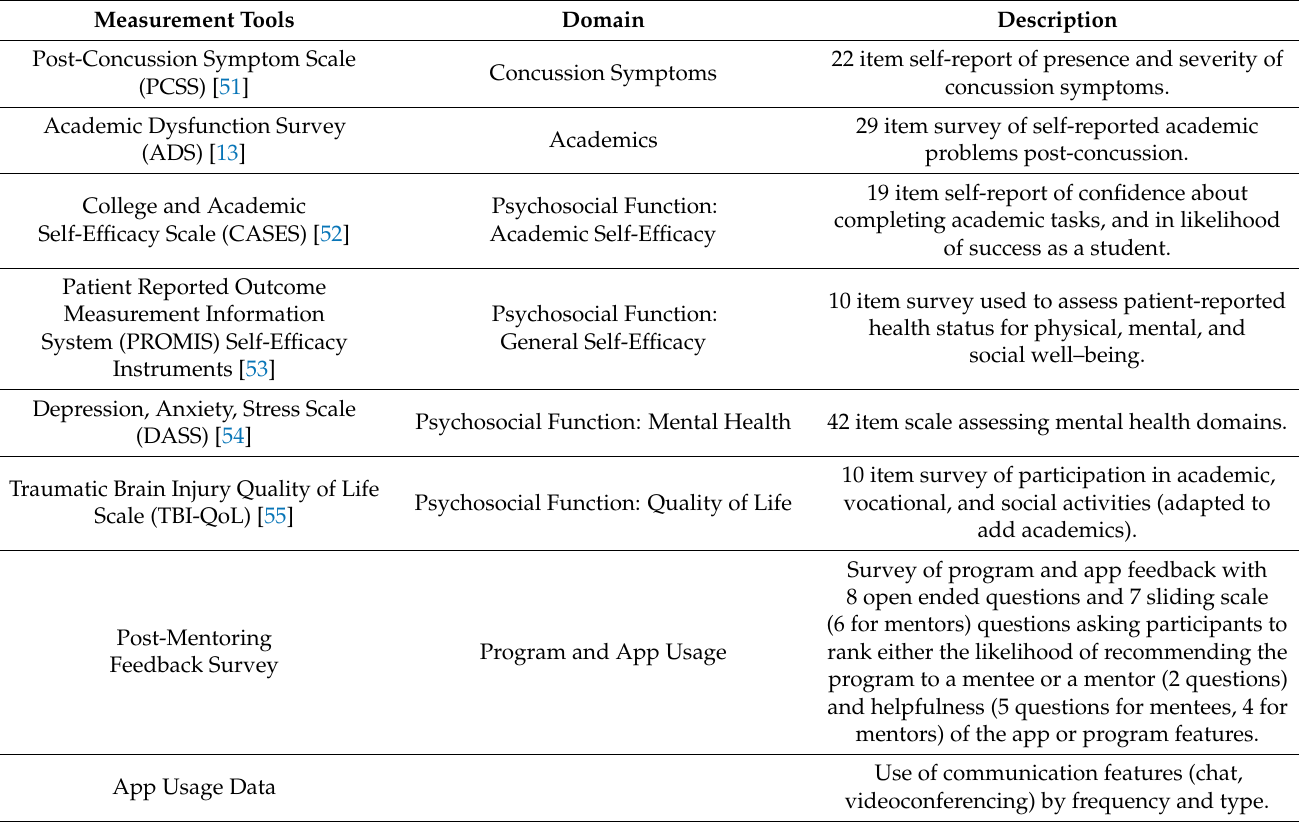
Table 2. Summary of SUCCESS data